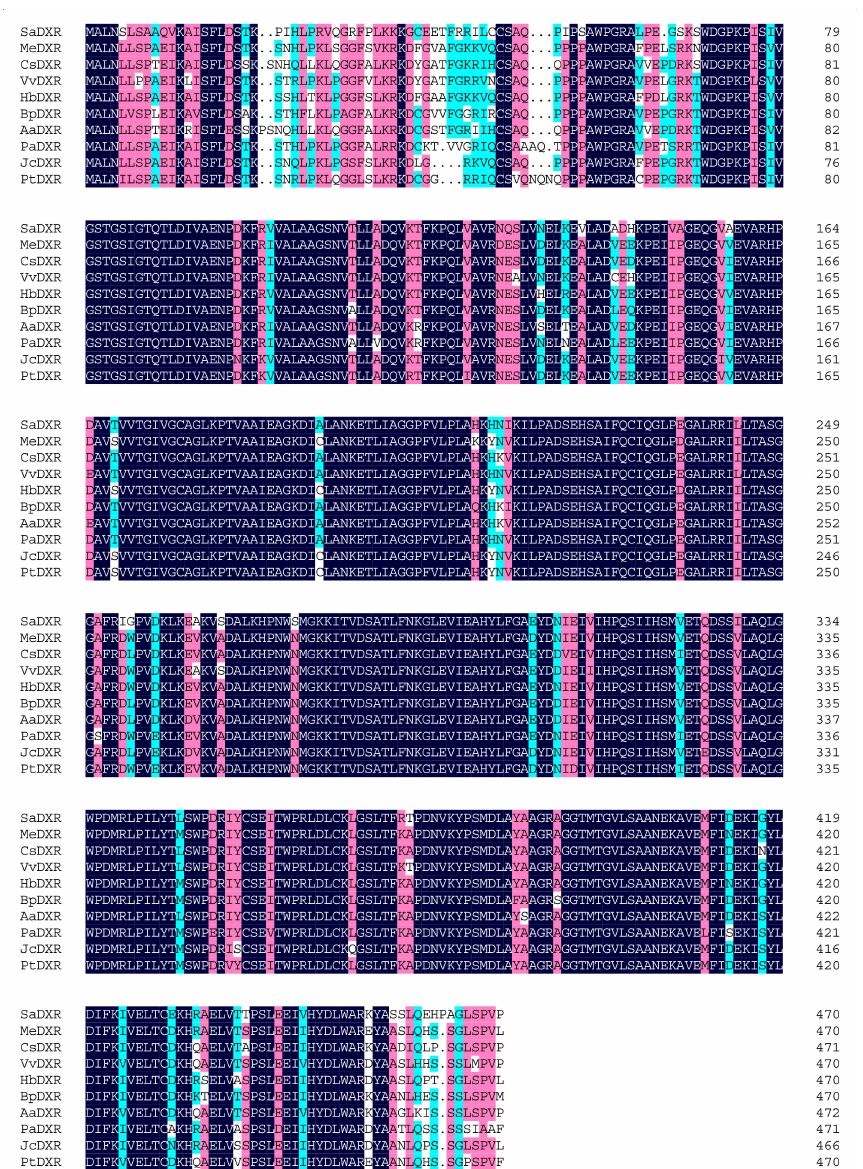
Figure 2. Alignment of deduced amino acid sequences of SaDXR, and related proteins from AaDXR ( Actinidia arguta , AID55340.1), BpDXR ( Betula platyphylla , AHX36947.1), CsDXR ( Camellia sinensis , AKE33276.1), HbDXR ( Hevea brasiliensis , XP_021669849.1), JcDXR ( Jatropha curcas , NP_001295720.1), MeDXR ( Manihot esculenta , XP_021616674.1), PaDXR ( Prunus avium , XP_021826007.1), PtDXR ( Populus trichocarpa , XP_002318048.2), and VvDXR ( Vitis vinifera , XP_002282761.1). The conserved NADPH binding motif (GSTGSIGT) and Cys-Ser-Ala motif are indicated by a horizontal line and asterisk, respectively. Alignments were performed with DNAMAN version 7. Black: 100% identity; pink: 75% ≤ identity < 100%; blue: 50% ≤ identity ≤